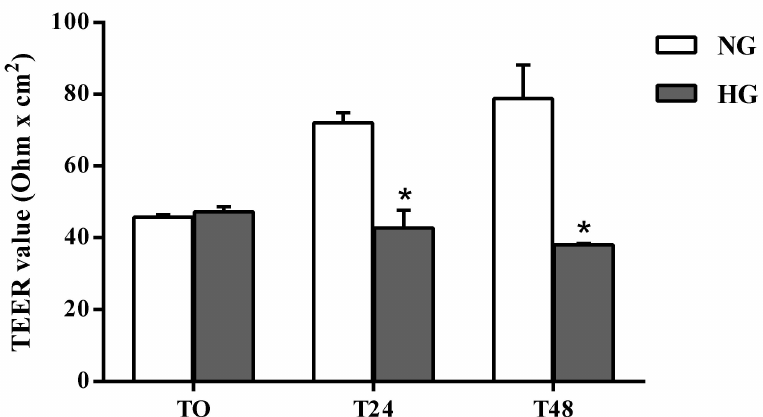
Figure 1. Assessment of barrier integrity in the in vitro human primary culture based triple co-culture BRB model by TEER. TEER values were measured at time 0 (TO), and after 24 (T24) and 48 (T48) h. NG = normal glucose condition (5 mM); HG = high glucose condition (40 mM). Values are means ± standard deviation (SD) of five independent experiments. Two-way ANOVA with Bonferroni’s post-hoc analysis. * p < 0.0001 vs. NG.